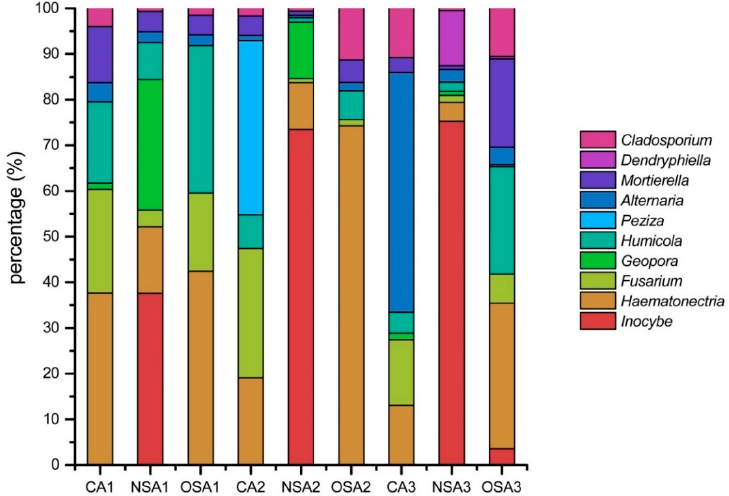
Figure 2. The main genera of